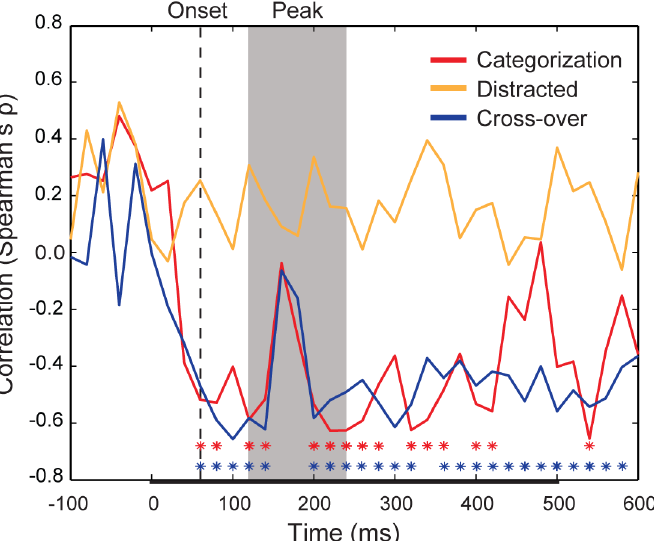
Fig 4. Time-series correlation between representational distances from the animacy boundary and categorization task reaction times. The time-varying rank-order correlation (Spearman ’ s ρ ) between the average object exemplar representational distance and average reaction time across subjects for the categorization task (red), distracted viewing task (orange), and cross-over between the tasks (blue), in which representational distances from the distracted viewing task were correlated with the median RTs for the categorisation task. Color-coded asterisks indicate time points at which a correlation between distance and RT achieves significance ( * = FDR adjusted p < 0.05). The decoding onset is indicated by dashed vertical line (60 ms). The period of peak decoding is indicated by the gray shaded region extending from 120 – 240 ms post-stimulus onset. The bar along the x-axis indicates the stimulus